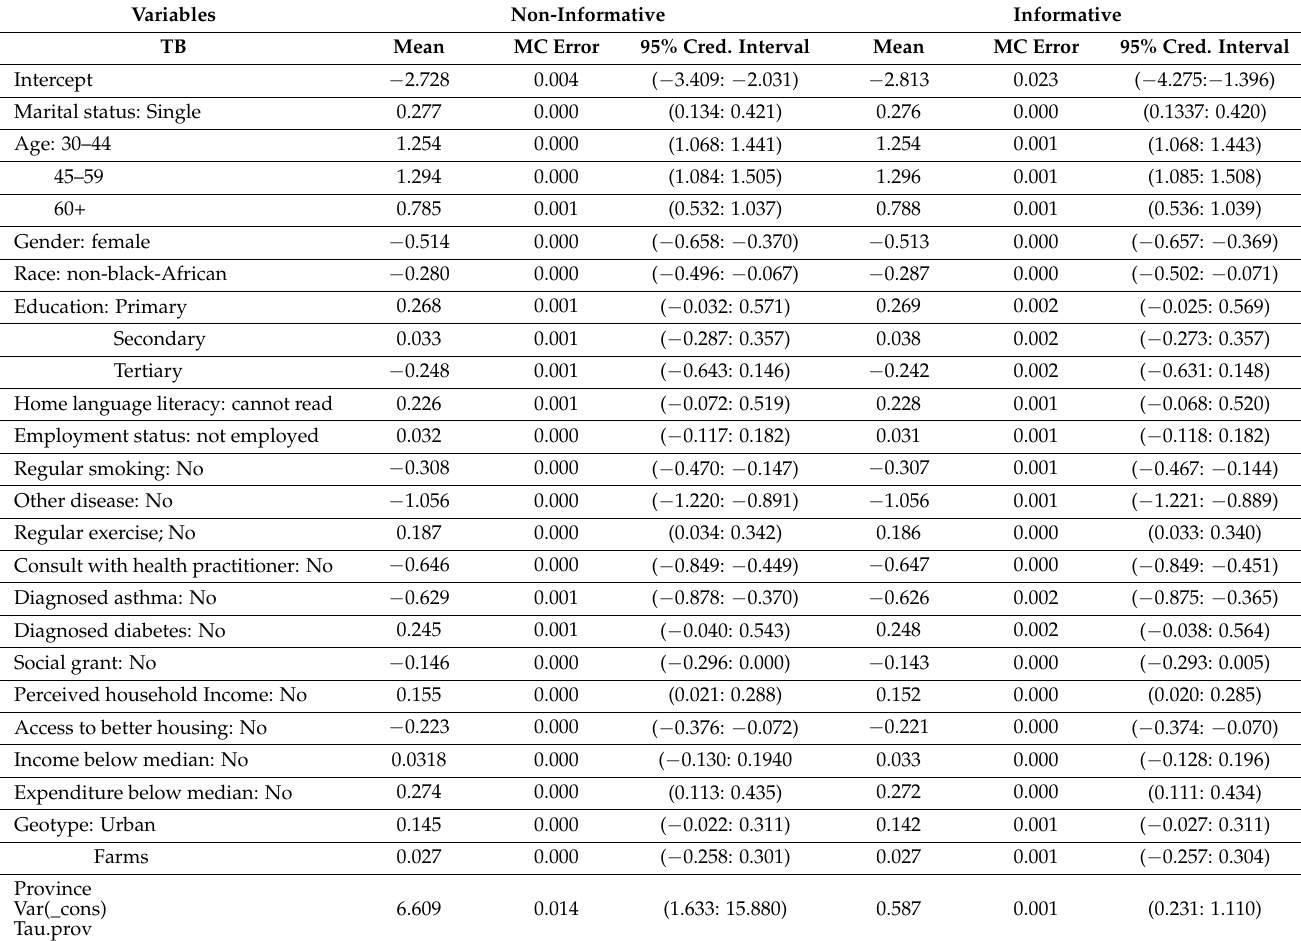
Table 2. Wave 5 Bayesian MLM informative versus non-informative